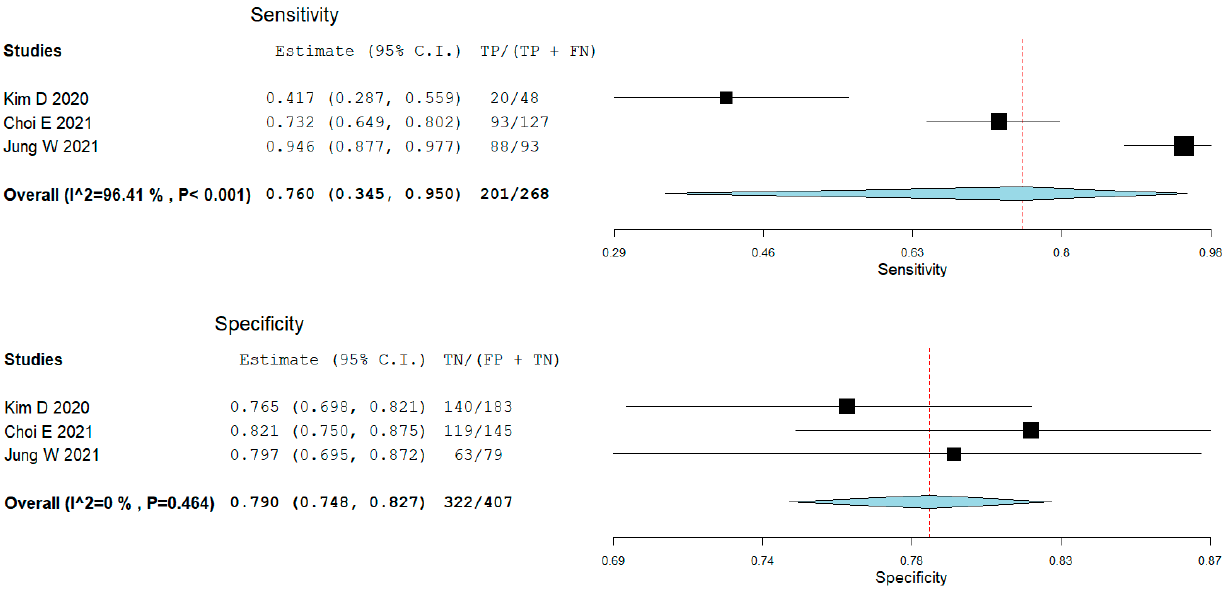
Figure 2. Forest plot for sensitivity and specificity of ResNet in classifying temporomandibular joint osteoarthritis (Choi [36], Jung, [16], Kim [37]).